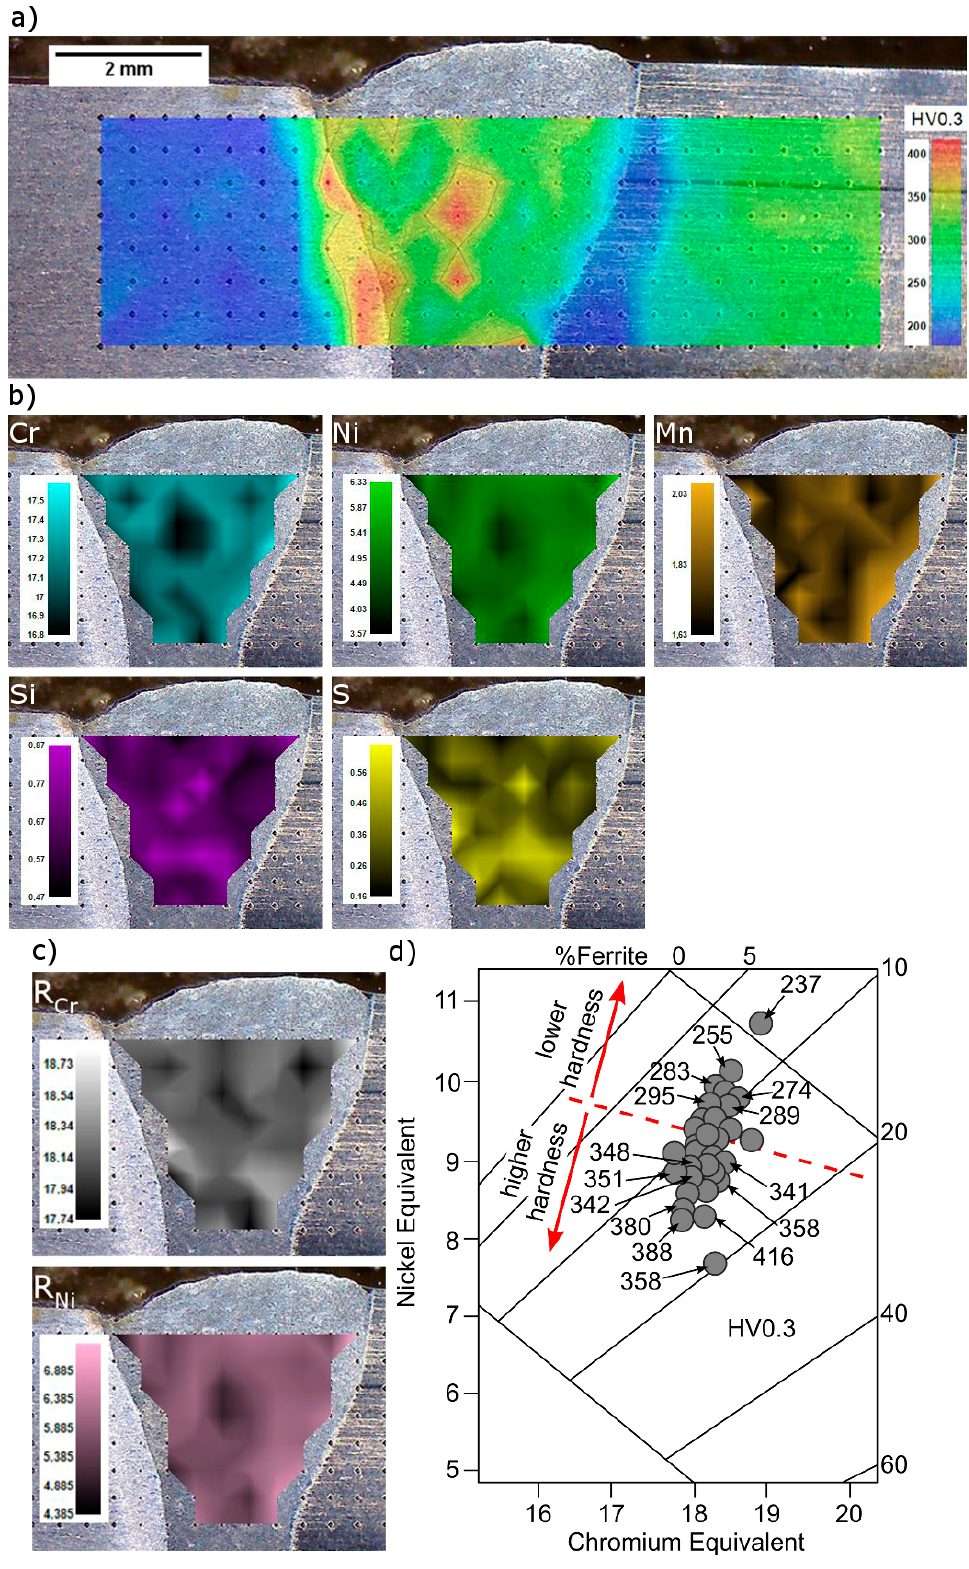
Figure 12. Hardness map of the joint and chemical composition distribution in weld metal. ( a ) hardness map; ( b ) chemical composition map; ( c ) chromium and nickel equivalents map; ( d ) hardness distribution depending on the chromium and nickel equivalents.